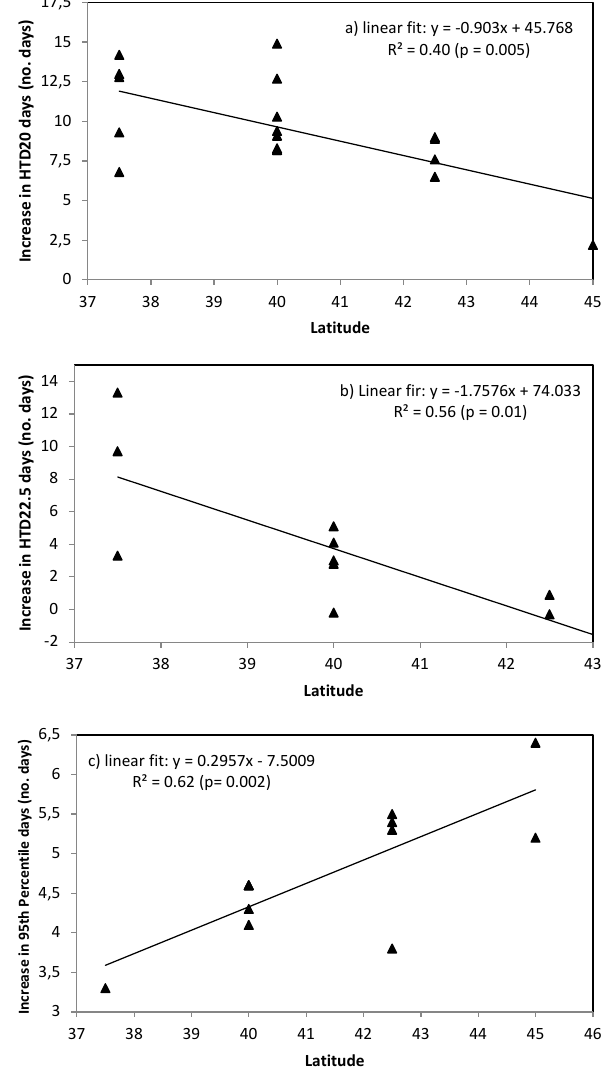
Figure 4. Linear regression showing the relationship between lati- tude and the change in the number of days with an air temperature at 850 hPa higher than (a) 20 ◦ C (HTD 20 ), (b) 22.5 ◦ C (HTD 22 . 5 ), and (c) the 95th percentile at 850hPa in the June–September period from 1978 to 2012. The analysis included only sites where signifi- cant temporal changes were identified.